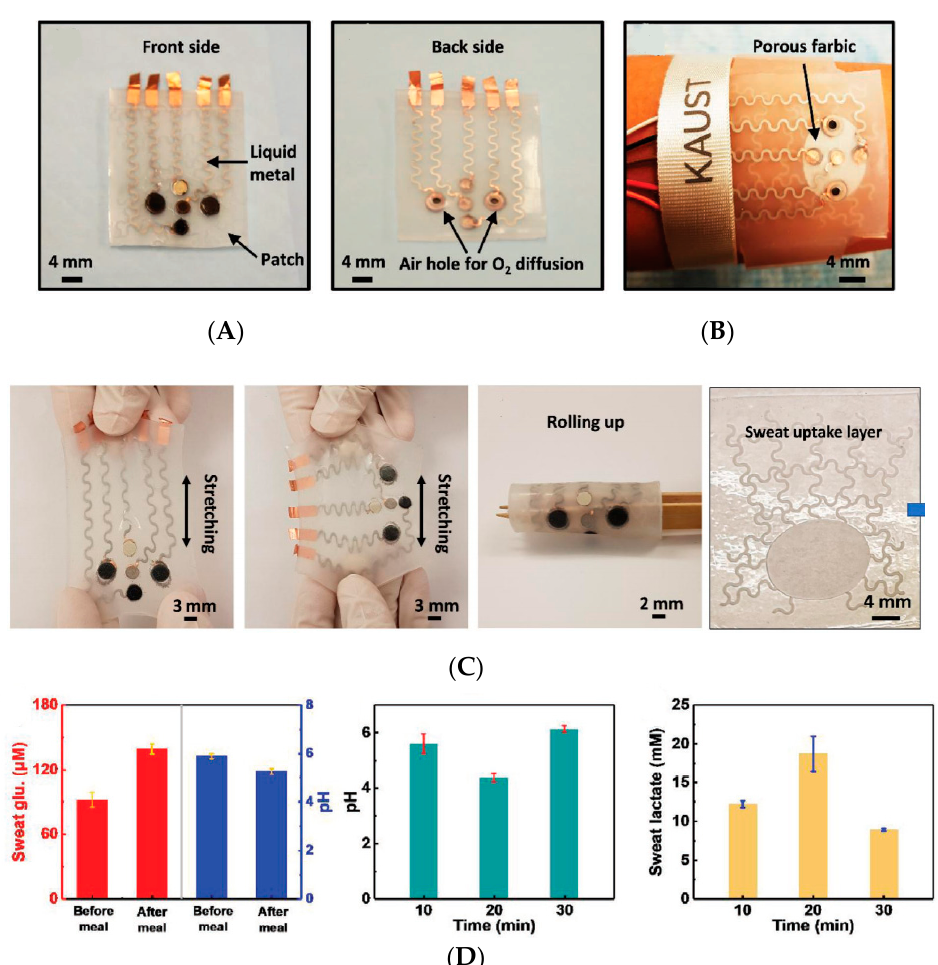
Figure 14. ( A ) Picture of the front and back sides (left, middle) of the sensor array with contacts, conductive tracks and electrodes (pH, lactate, and glucose). Right: Sensor wristband on subject’s forearm. ( B ) Stretching in both directions and rolling up. ( C ) Patterned underlayer for sweat collection. This layer, which is put in direct contact with the skin, is the backside of the sensors layer. ( D ) Glucose, pH, and lactate monitoring on a subject’s forearm before and after meal, and during effort (maximum effort at 20 min). Reproduced from [54] with permission. © 2019 WILEY-VCH Verlag GmbH & Co. KGaA, Weinheim.